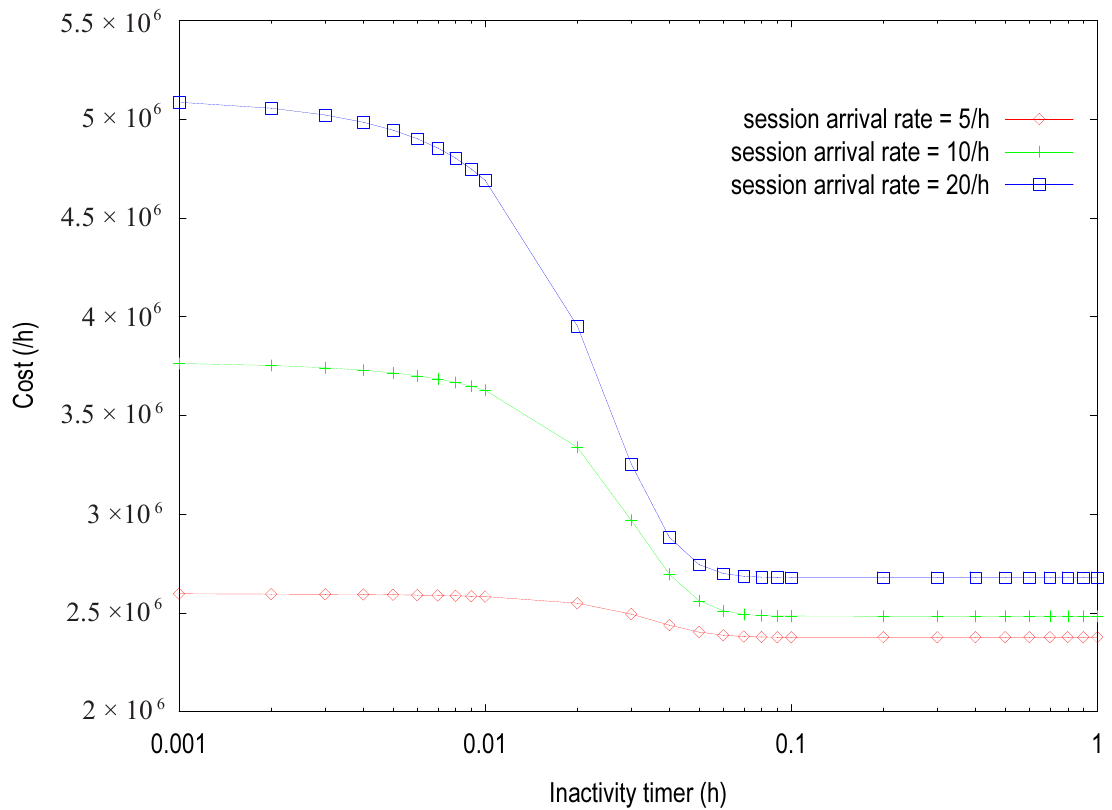
Figure 9. Cost by varying the session arrival rate (large values of T